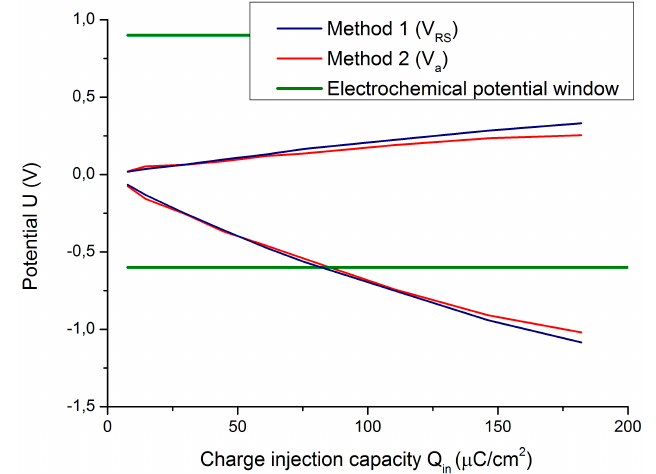
Figure 13. Extreme polarization values for electrode B calculated by method 1 (blue line) and method 2 (red line) as a function of injected charge.